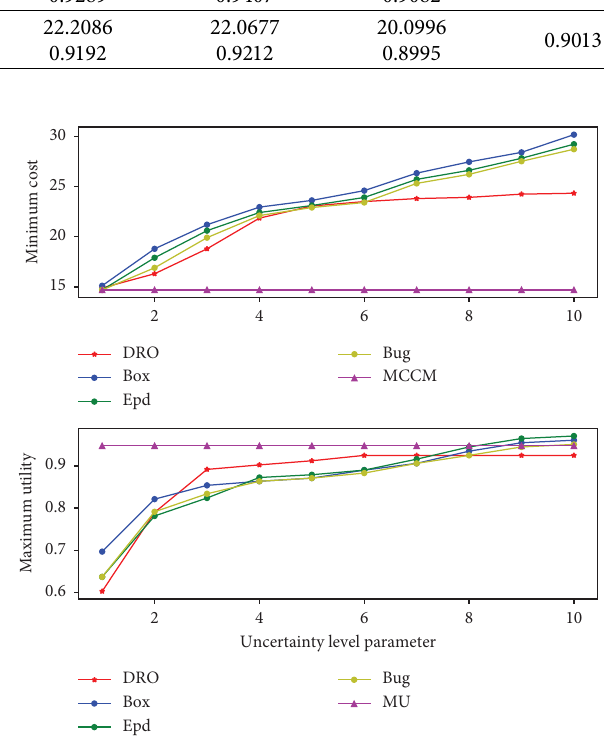
Figure 1: Scenario 1: minimum cost and maximum utility of diferent MCCMs under diferent